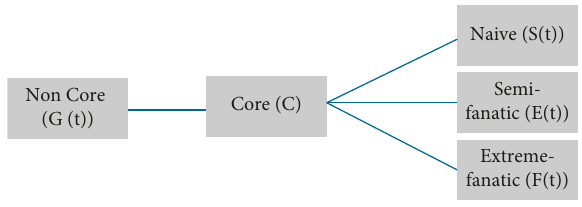
Figure 1: Stratified model